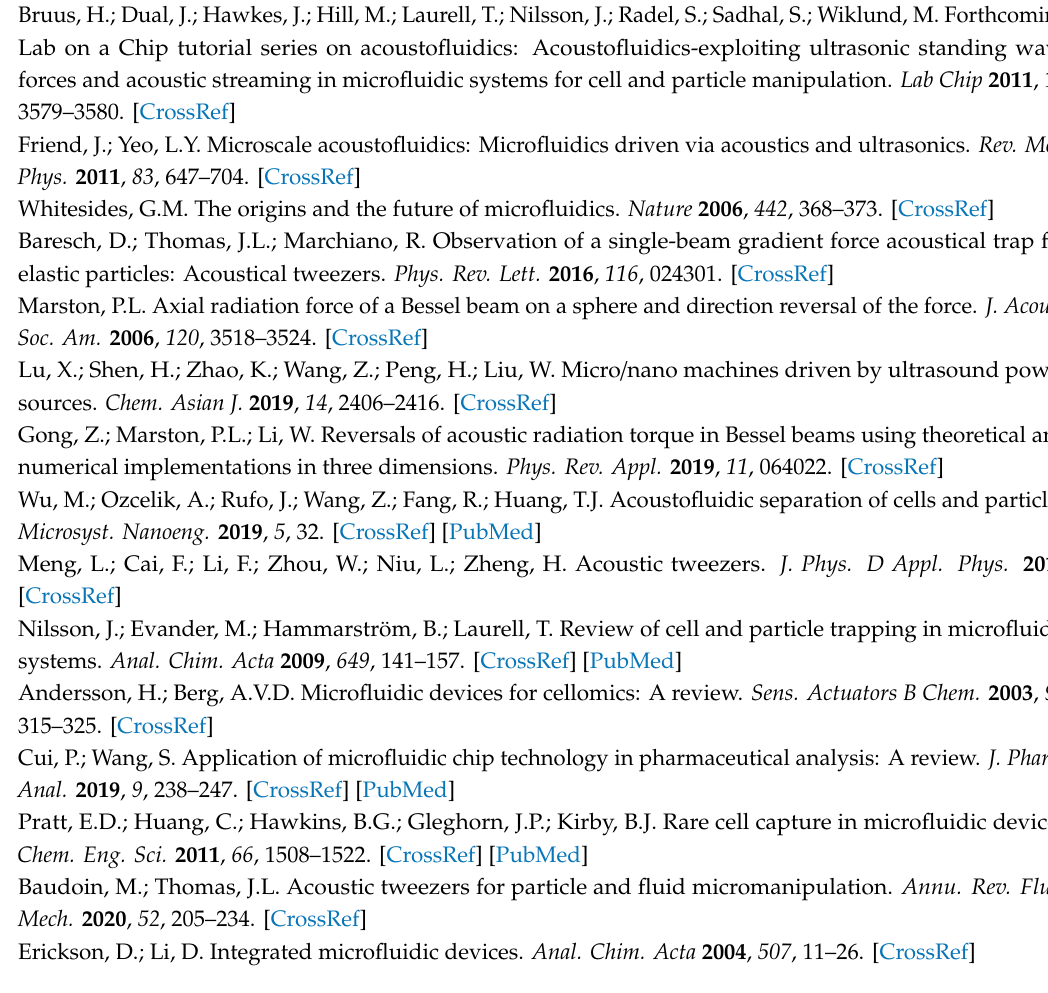
Figure S1: (Color online). Acoustofluidic field excited by four vibration sources with the same initial phase. (a) Acoustic radiation force magnitude. (b) Acoustic streaming induced starting drag force magnitude, Figure S2: (Color online). Acoustofluidic field excited by four vibration sources with di ff erent initial phases. (a) Acoustic radiation force magnitude. (b) Acoustic streaming induced starting drag force magnitude, together with a COMSOL simulation file of Figure